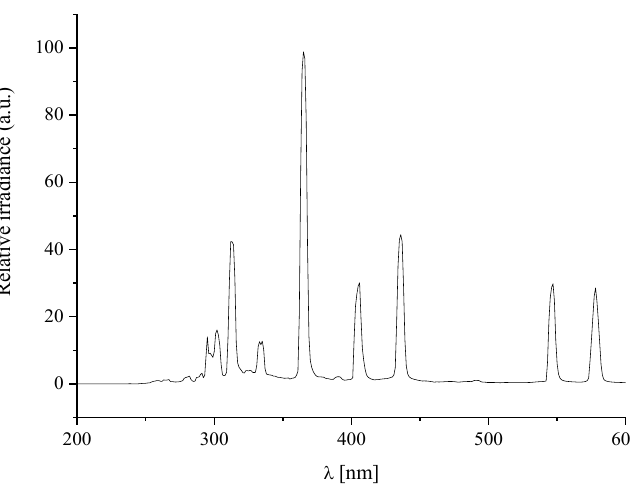
Figure 9. Spectrum of the Sylvania UV lamp (mercury, 125 W).